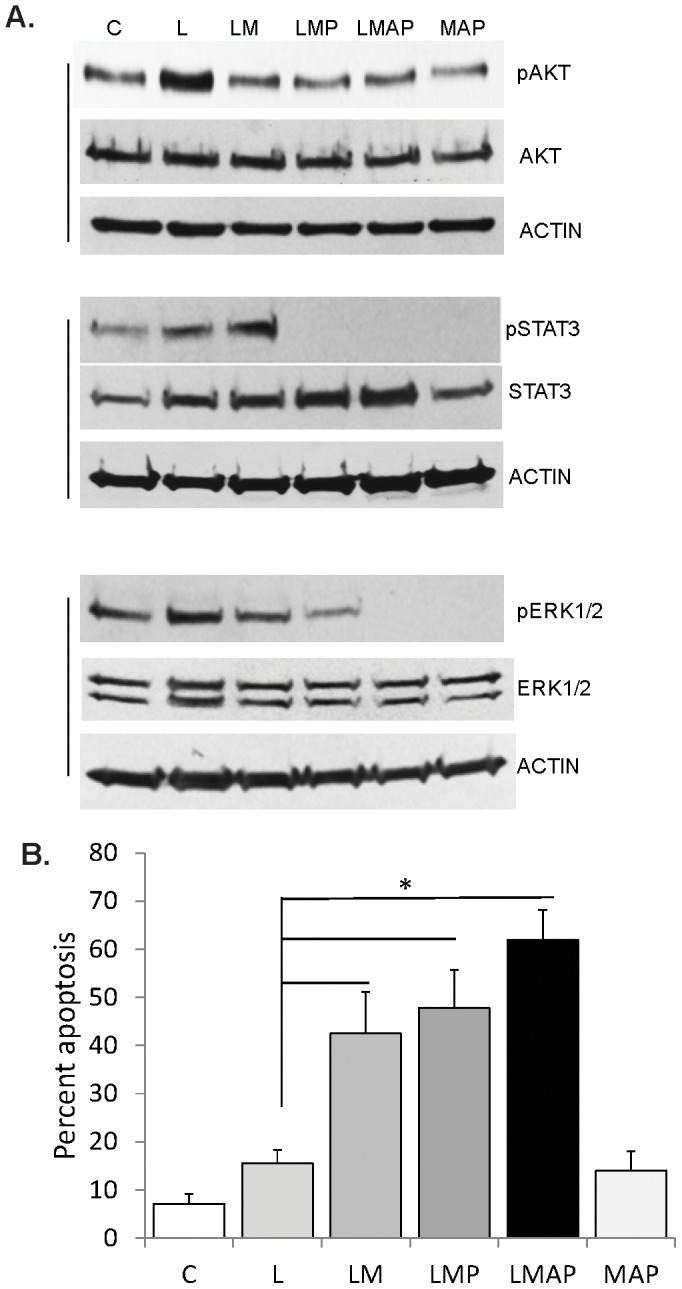
LBH589-induced apoptosis is augmented by suppressing three survival pathways.A. Western blot analyses of HCT-R CRC cells exposed to mock (C) treatment, 50 nM LBH589 (L), 1 µM MK2206 (M), 0.5 µM AZD6244 (A), or 1 µM pyridone 6 (P) for 20 hours. Equal number of cells were lysed directly in Laemmli buffer and analyzed for expression levels of phosphorylated and total levels of AKT, ERK1/2, and STAT3. B. Apoptotic analyses of HCT-R cells exposed for 48 h to the treatments described in (A). Asterisk indicates statistically significant differences (P<0.05) between the apoptotic levels. Additional statistically significant differences are indicated in the text.